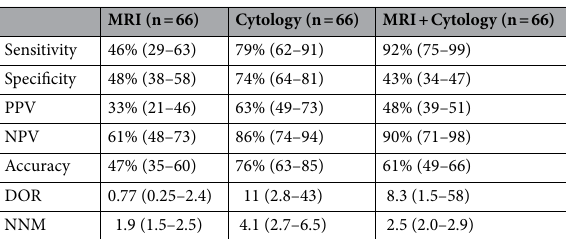
Table 6. Performance of noninvasive diagnostic modalities for pathologically confirmed Tis lesion without synchronous pT1-4